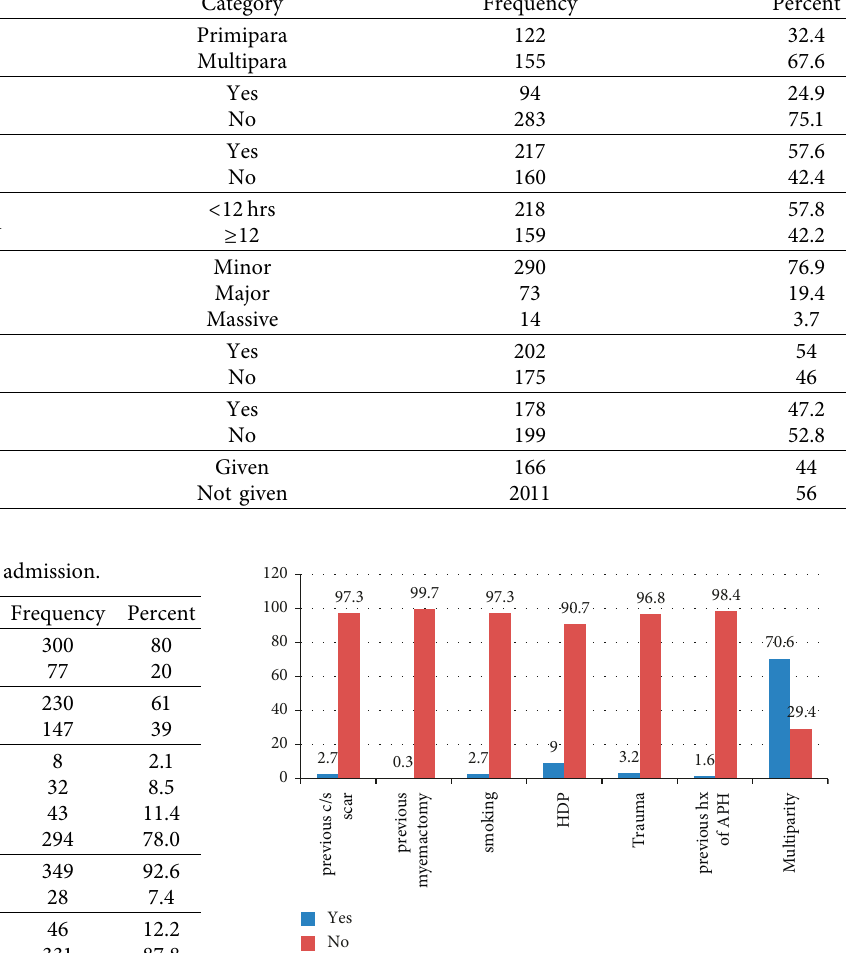
Figure 1: Risk assessment of women admitted with antepartum Table 4: Maternal condition at